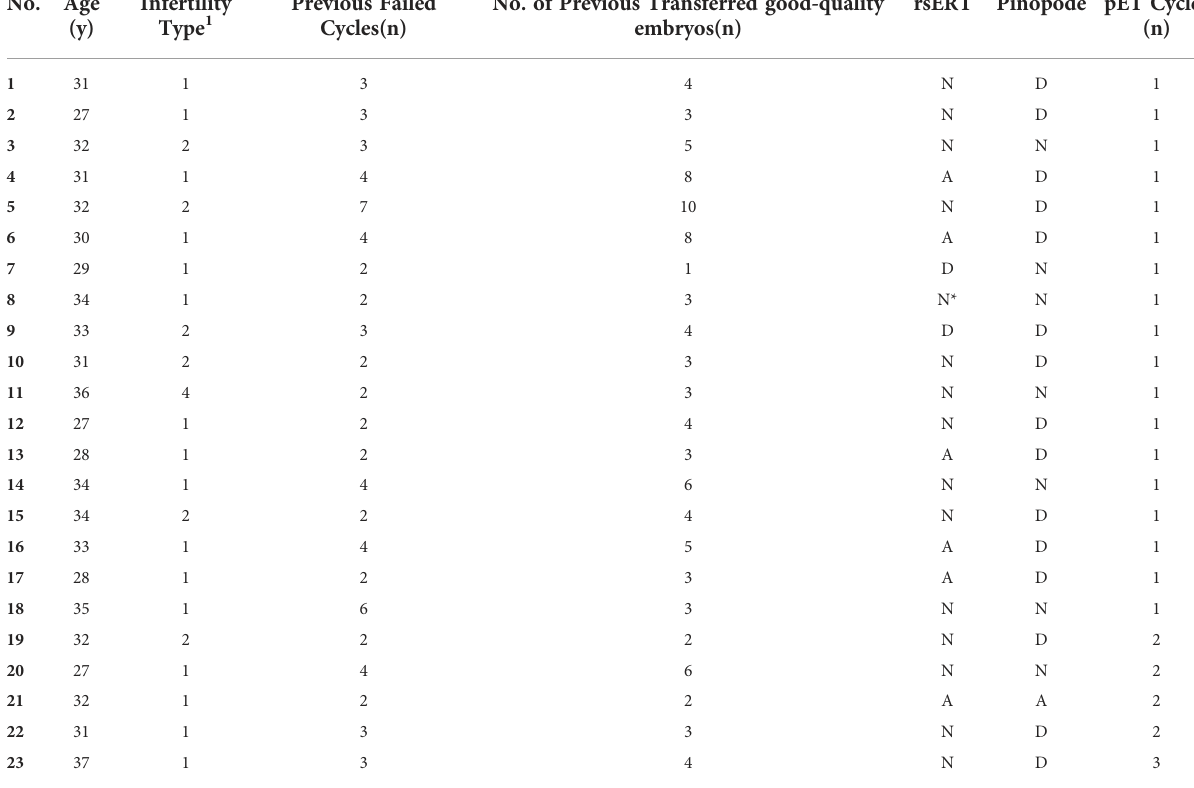
TABLE 1 Basic information and predicted optimal WOIs of the 23 pregnant patients. No. Age